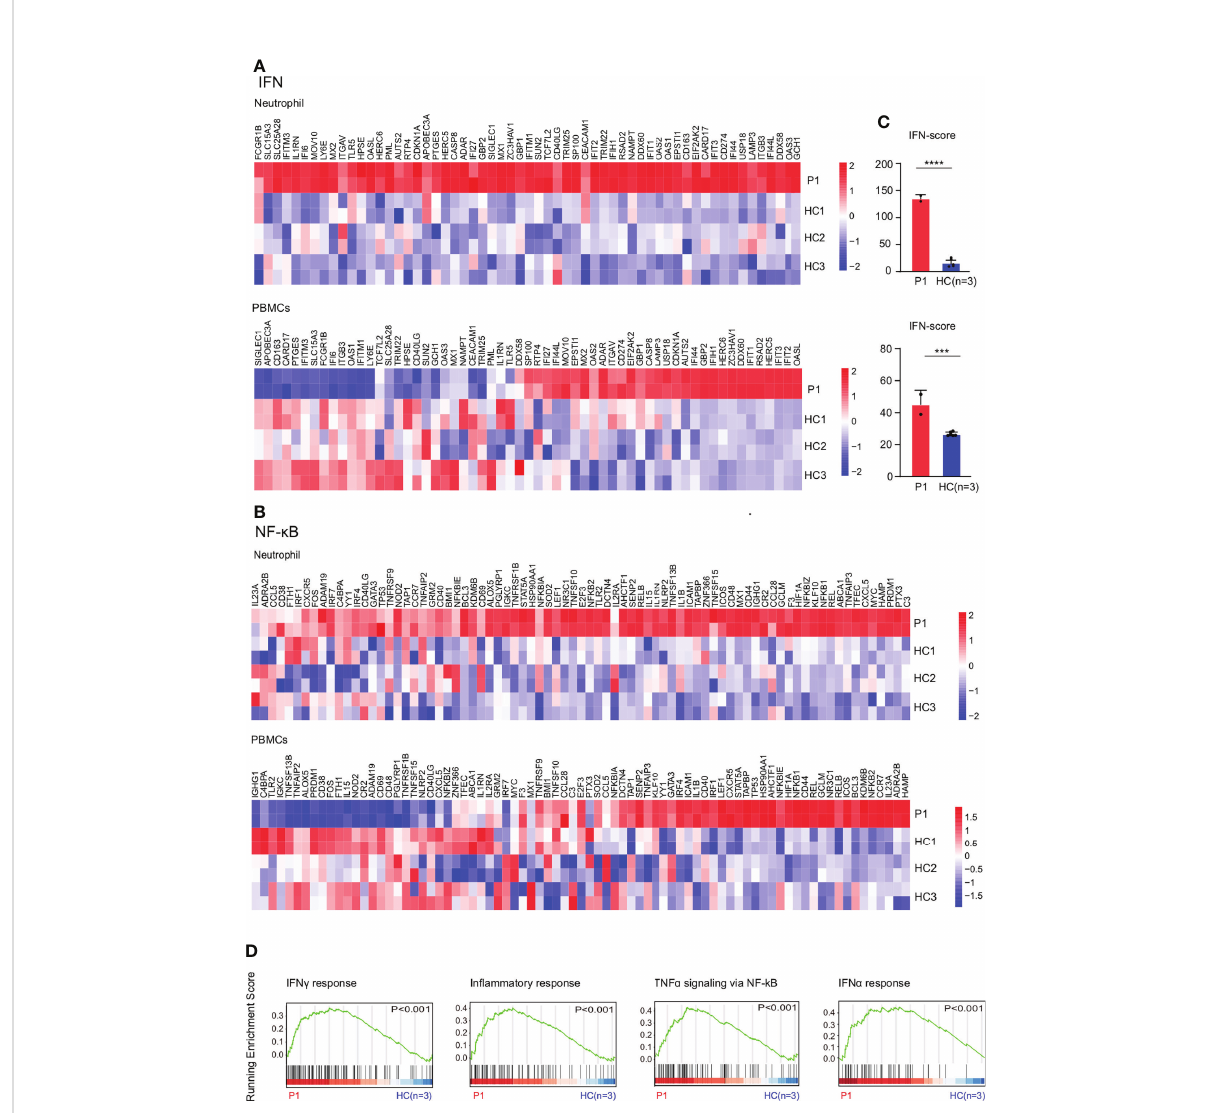
FIGURE 3 Expression patterns of genes involved in IFN and NF- k B by RNA sequencing. (A) Upregulation of IFN pathway in neutrophils and PBMCs of the patient1 compared with three healthy controls. (B) Upregulation of NF- k B pathway in neutrophils and PBMCs of the patient1 compared with three healthy controls. (C) IFN response gene scores (28 genes) in neutrophils and PBMCs of the patient1 and healthy controls, determined with RNA sequencing data. (D) GSEA plot of IFN- g response, in fl ammatory response, tumor necrosis factor – a (TNF- a ) signaling via NF- k B, and IFN a response in neutrophils from the patient1 and controls. ****p<0.0001.